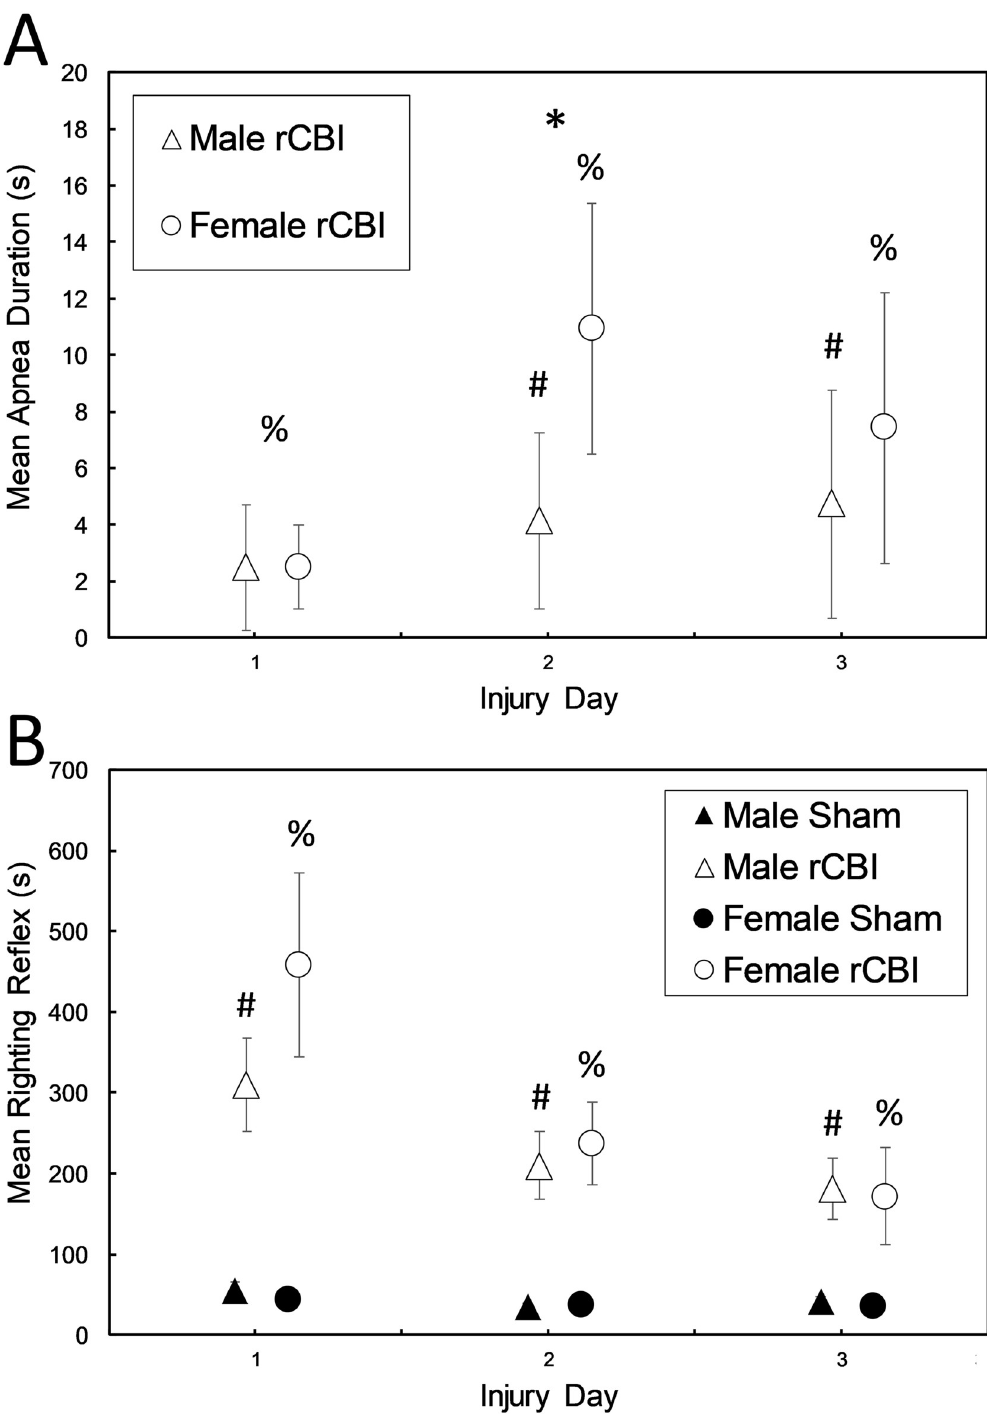
Fig 3. Apnea (A) and righting reflexes (B) following concussive brain injuries. (Shown are means +/- 95% confidence intervals, based on z -scores). On Day 1, only the injured female mice had a significant amount of apnea compared to female sham-control mice ( A , %, Female rCBI > Female Sham, p < 0.01). (Note that sham-controls did not experience apnea and all have a value of “0.”) Both sexes had significant durations of apnea compared to sham controls on the second day of injury (%, Female rCBI > Female Sham, p < 0.0001; #, Male rCBI > Male Sham, p < 0.05); also, female injured mice had longer durations of apnea than male mice ( � , Female rCBI > Male rCBI, p < 0.05). On the third injury day, both sexes had significant durations of apnea following injury (%, Female rCBI > Female Sham, p < 0.0001; #, Male rCBI > Male Sham,